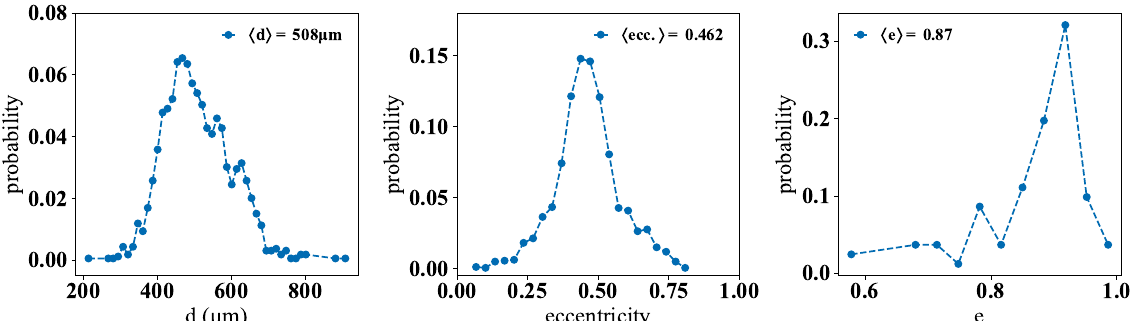
Figure 4. Left: Probability distribution of the grain sizes for the experiments reported here. Center: Probability distribution of the eccentricity (a measure of the deviation from a circle) for the grains. Right: Probability distribution of the coe ffi cient of restitution of the grains. The distributions of d and ecc. can be well approximated by a gaussian distribution.